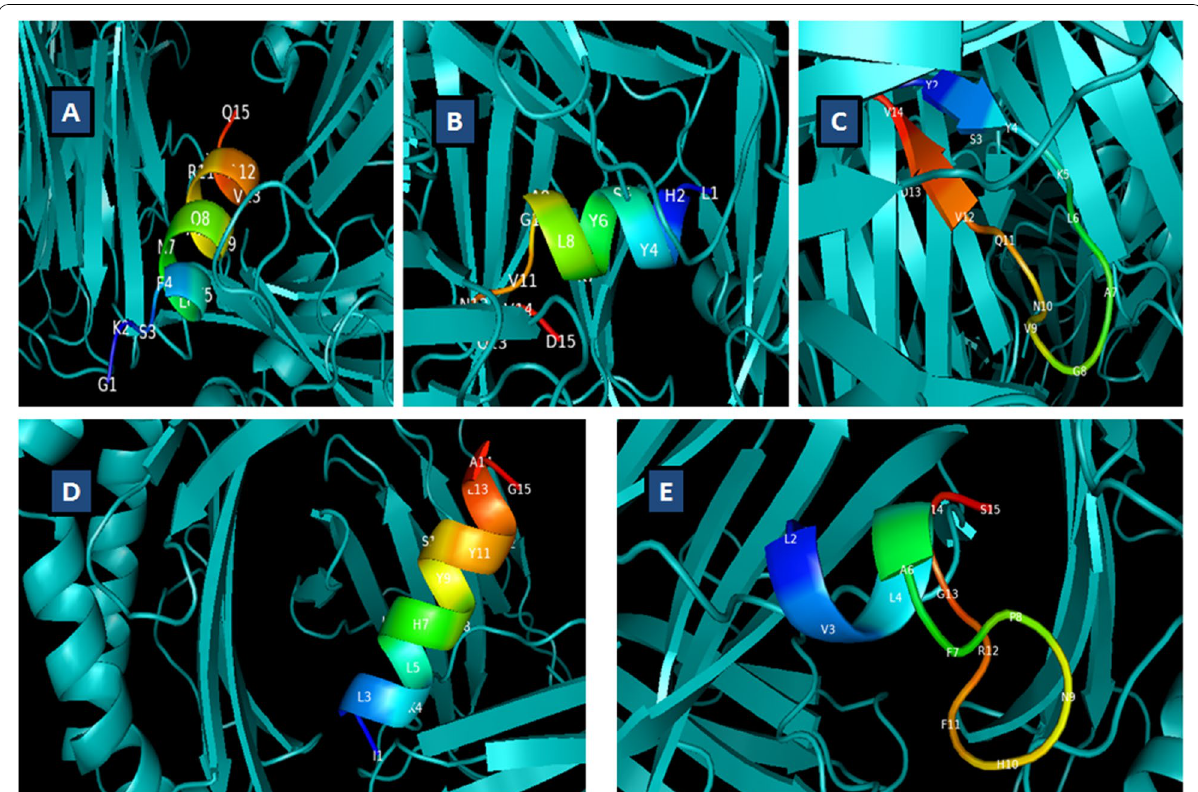
Fig. 3 Docked complexes of epitopes with HLA-allelic determinants. A 1AQD-GKSFELNQAARAVTQ. B 1AQD-LHRYSYKLAGVNQVD.